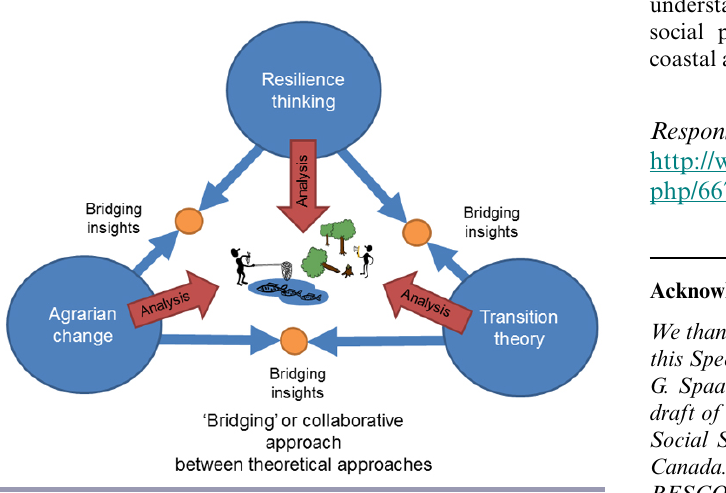
Fig. 2 . Collaboration between theories in sharing insights with resilience